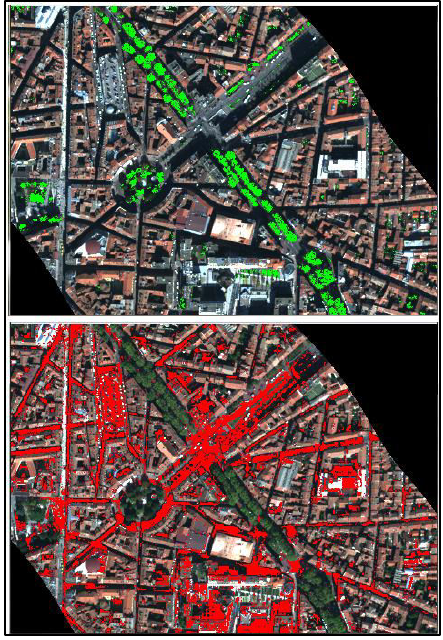
Figure 8. Vegetation (green) and roads (red) classes identified by supervised classification